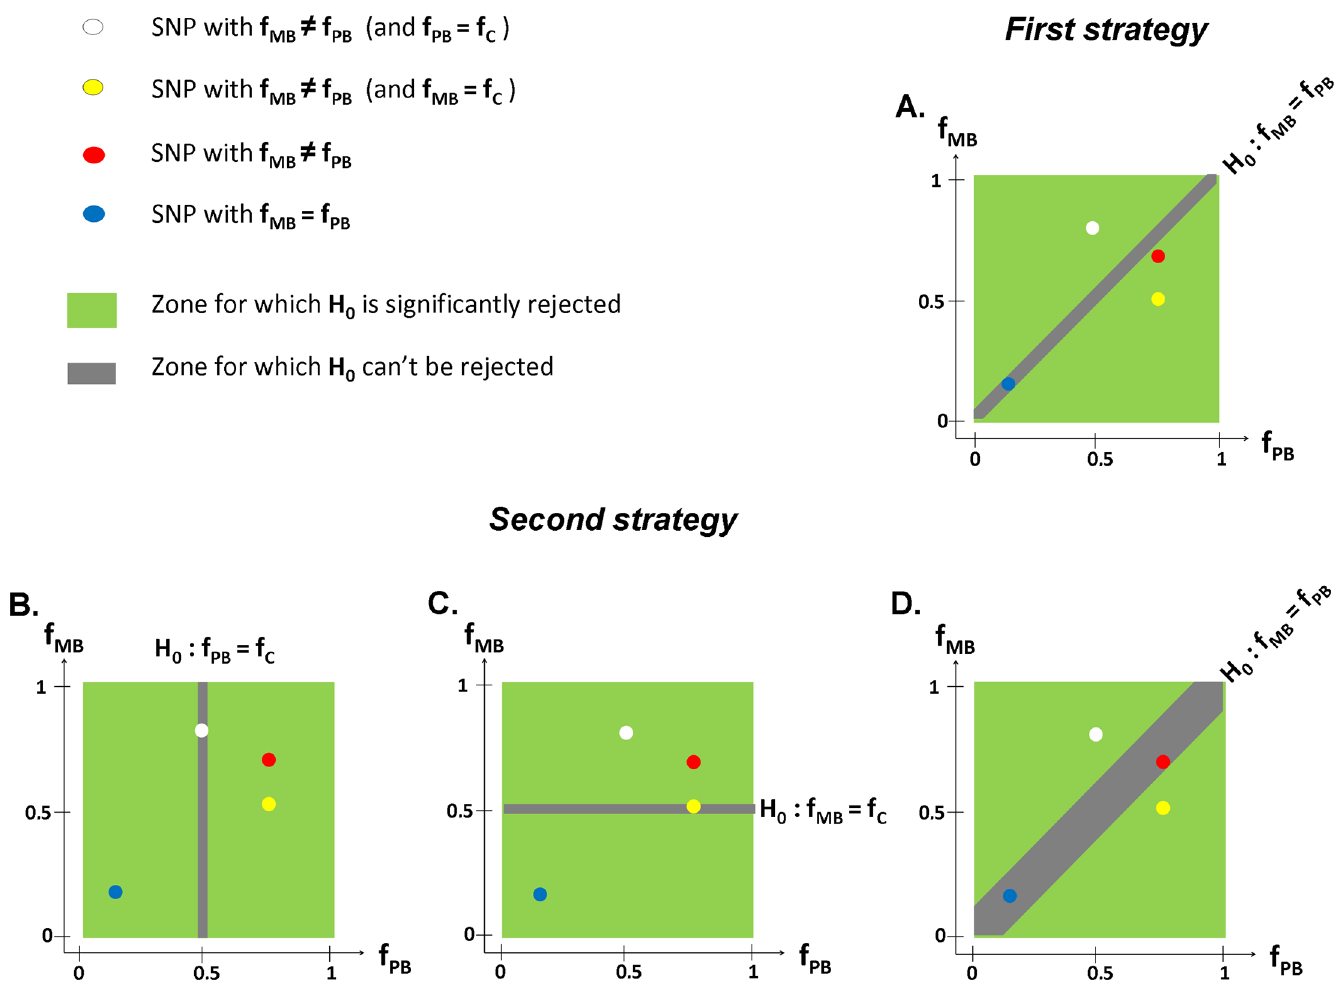
Fig 4. Statistical impact of the hypothesis used to test for an association between a genetic variant and leprosy polarization. In the common case-control study design, a standard test of association between a genetic variant and the phenotype under study is to compare allelic frequencies (f) between the group of cases and the group of controls. Here, we consider a sample including an even number of controls and leprosy cases, equally distributed between PB and MB. In addition, we fixed the frequency of the allele of interest to 0.5 among the controls (f C = 0.5). In each panel, f PB and f MB (x and y axis) are the allele frequencies among PB and MB individuals, respectively. The first strategy directly compares MB to PB cases (Panel A). The second strategy first tests PB versus controls (Panel B) and MB versus controls (Panel C) before performing a heterogeneity test MB versus PB, possibly after testing leprosy per se versus controls (panel D). The red SNP is a variant for which f MB 6¼ f PB and for which the association is significant with the first strategy but not with the second (the red SNP is in the gray area where the null hypothesis H 0 cannot be rejected). This second strategy is indeed hampered by correcting for multiple testing (testing MB versus PB after testing PB versus controls and MB versus controls) as well as the usual low power of heterogeneity